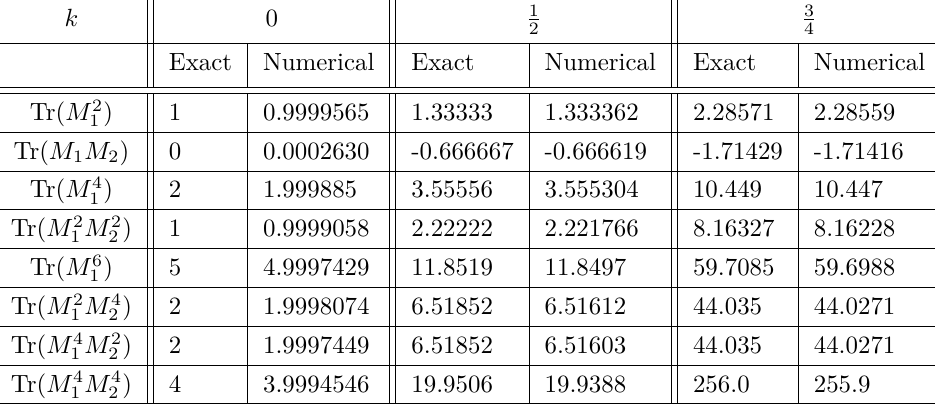
Table 6. Results for g 3 = g 4 = 0 as k is varied. The table shows loops with length ≤ 8 .